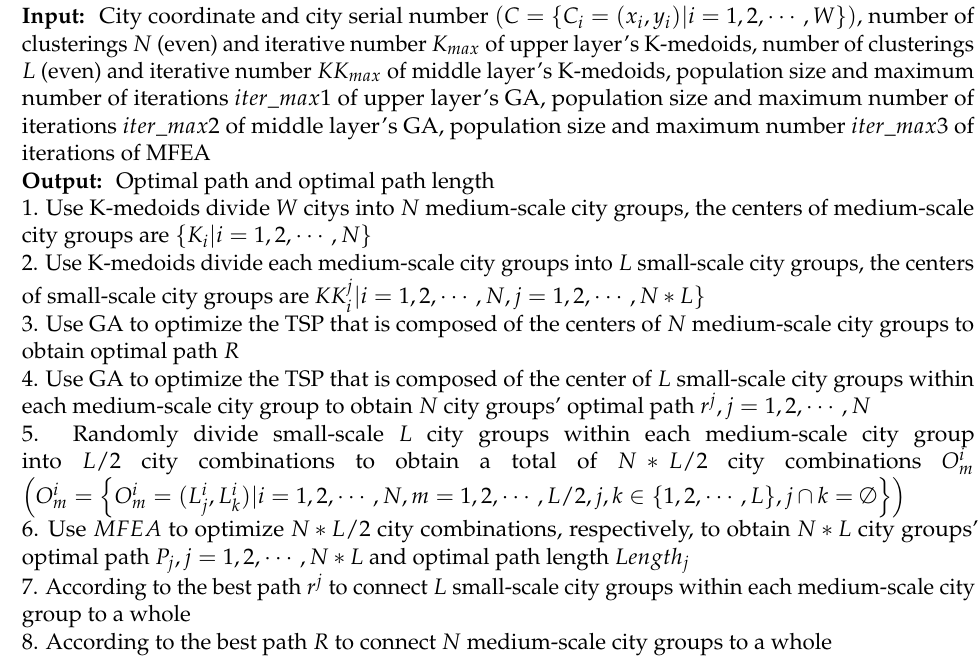
Algorithm 1 Three-Layered Evolutionary Optimization